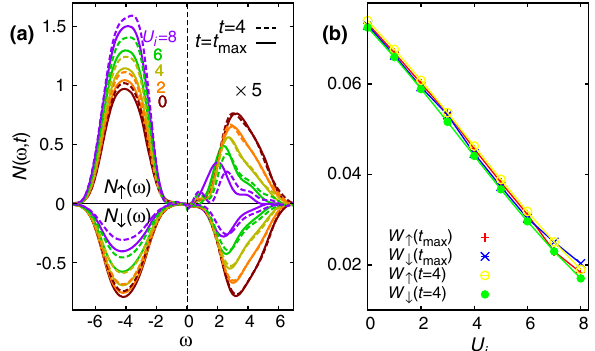
FIG. 6. (a) Occupied density of states N σ ð ω ; t Þ after the quench: t < 0 : v ¼ 0 (Néel state); 0 ≤ t < 0 . 5 : v ¼ 1 , U ¼ U v ¼ 1 , U ¼ 8 , for various values of U refer to majority and minority spin, respectively, and the upper Hubbard band is scaled by a factor of 5. Dashed and solid lines denote time t ¼ 4 and the largest simulation time t ¼ t respectively. (b) Integrated weight in the upper Hubbard band (red crosses and blue